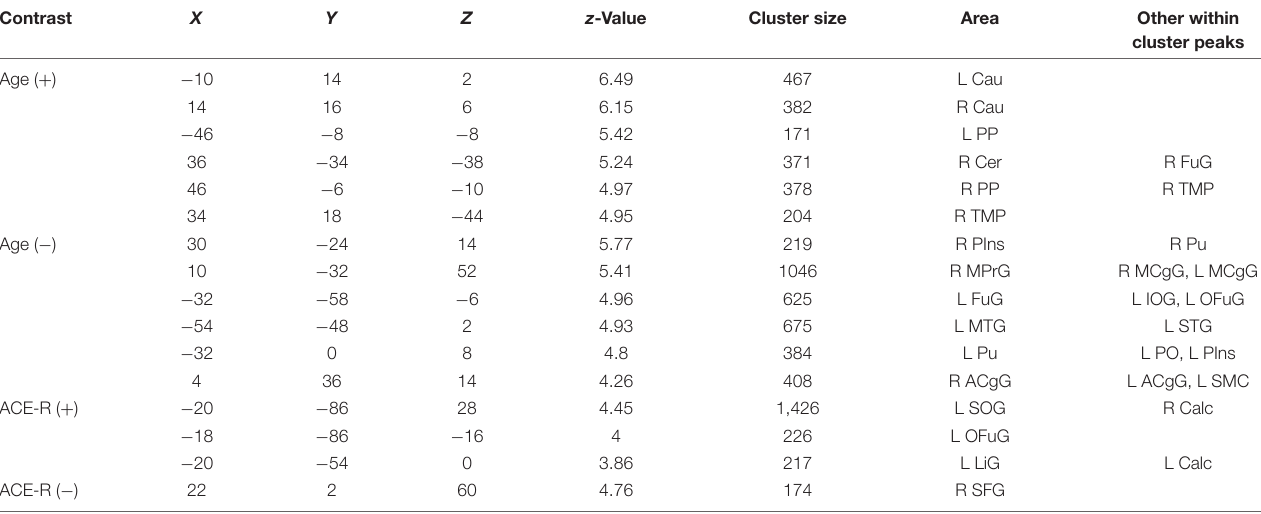
TABLE 3 | Regions showing significant (FWEc p < 0.05, CDT p = 0.001) relationship between short-range ICC values and age and ACE-R total score. Contrast X z -Value Cluster size